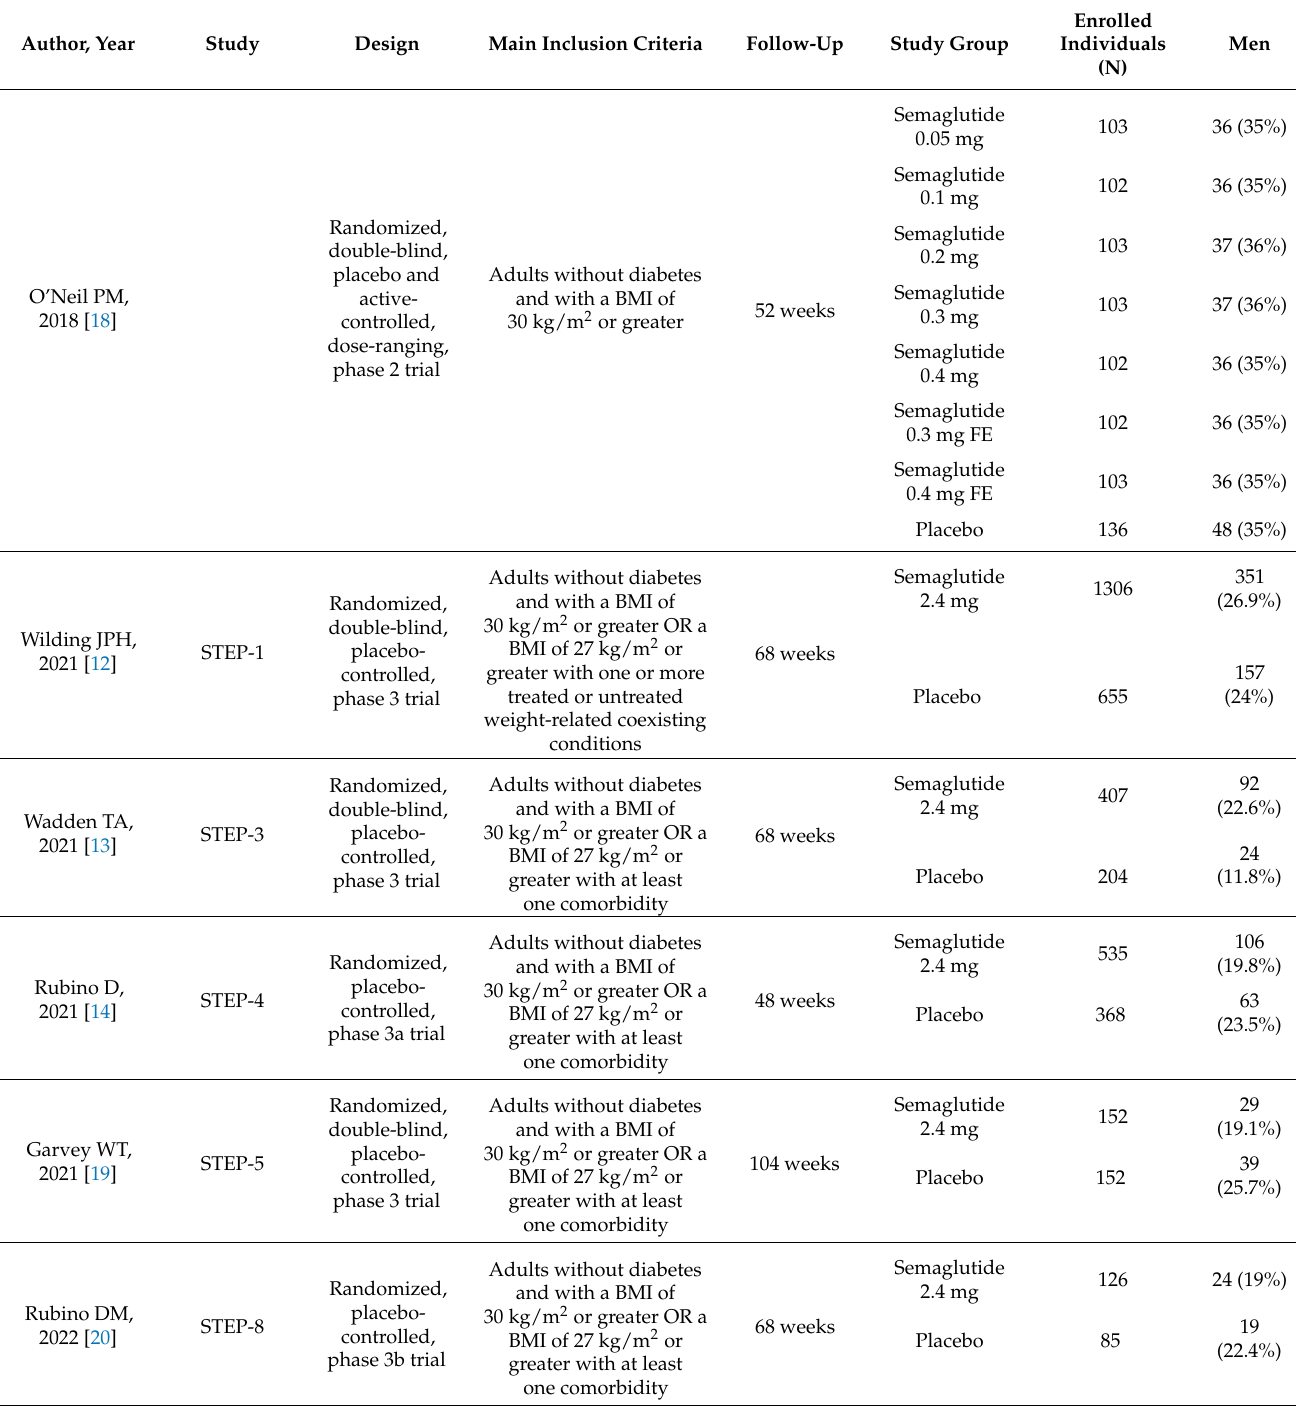
Table 1. Main characteristics of the clinical trials included in the systematic review and